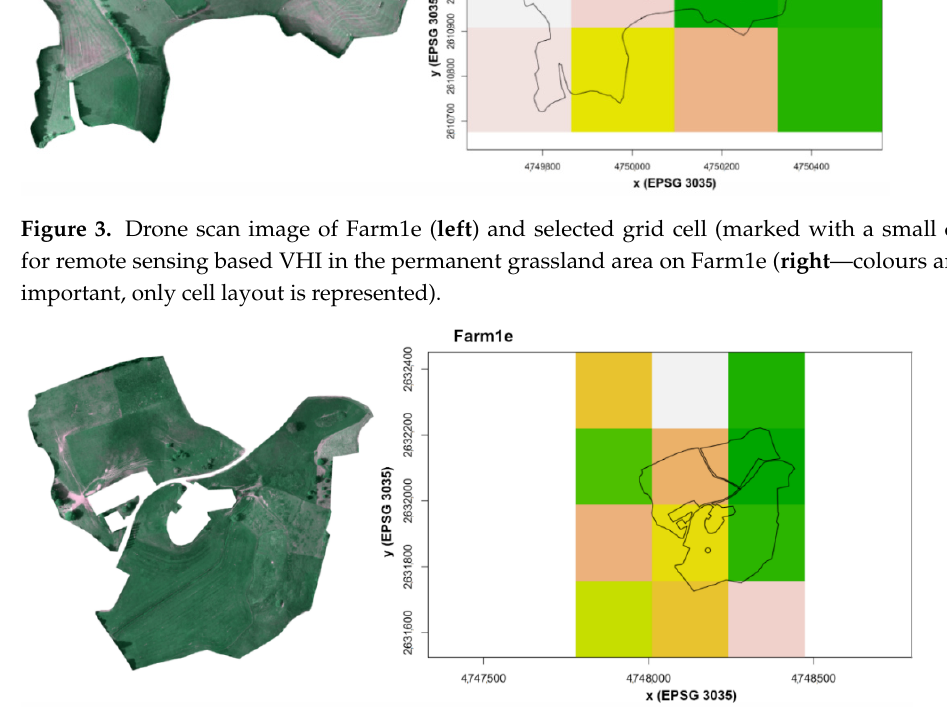
Figure 4. Drone scan of Farm2 ( left ) and selected grid cell (marked with a small circle) for remote sensing based VHI in the permanent grassland area on Farm2 ( right —colours are not important, only cell layout is